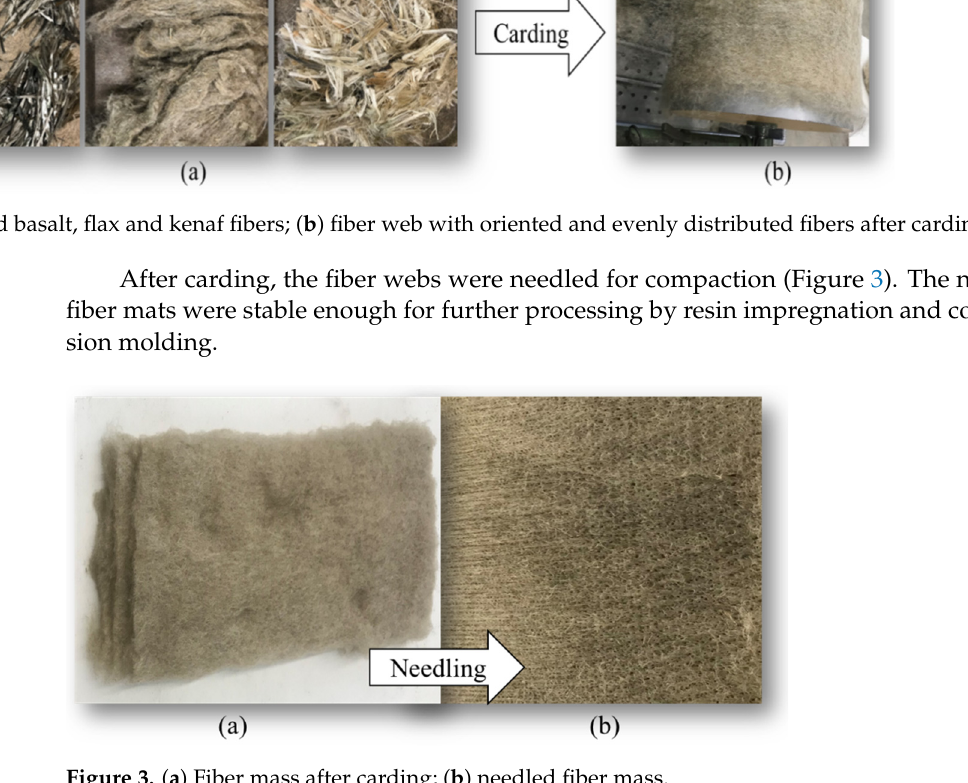
Figure 3. ( a ) Fiber mass after carding; ( b ) needled fiber mass.